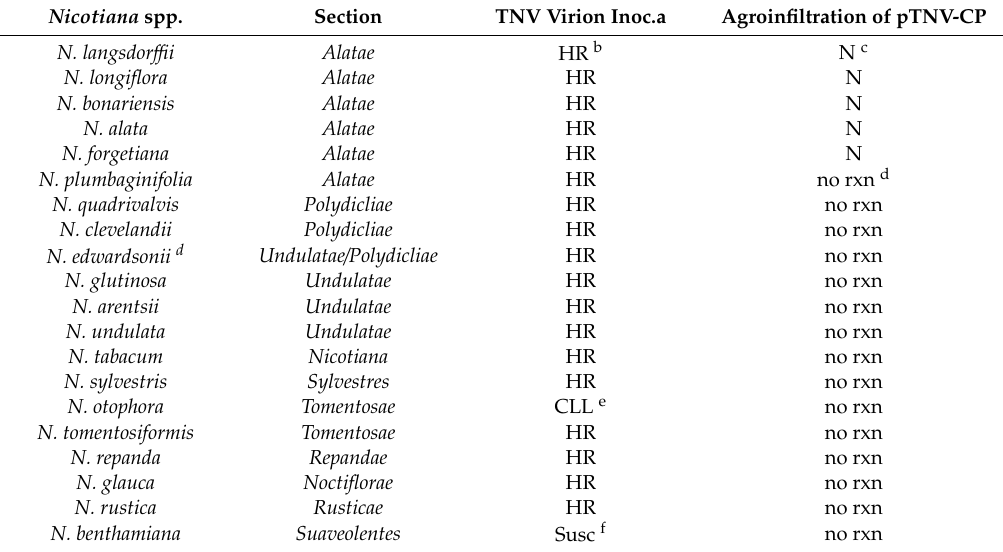
Table 1. Response of 20 Nicotiana species to inoculation with TNV virions and agroinfiltration of the pTNV-CP. Nicotiana spp. TNV Virion Inoc.a Agroinfiltration of pTNV-CP